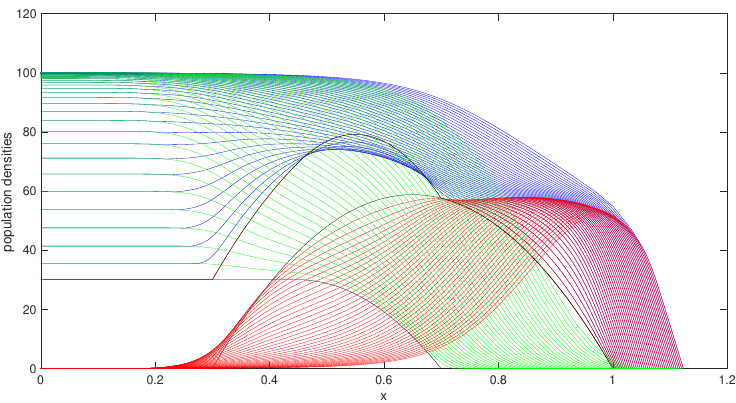
Figure 3. Result of the competition–diffusion model at t = 10. Here, we use δ 1 = δ 2 = 0.001, K 1 = K 2 = 1, k 1 = 100, k 2 = 60, r 1 = r 2 = 1, and µ = 50. The restriction on the carrying capacity